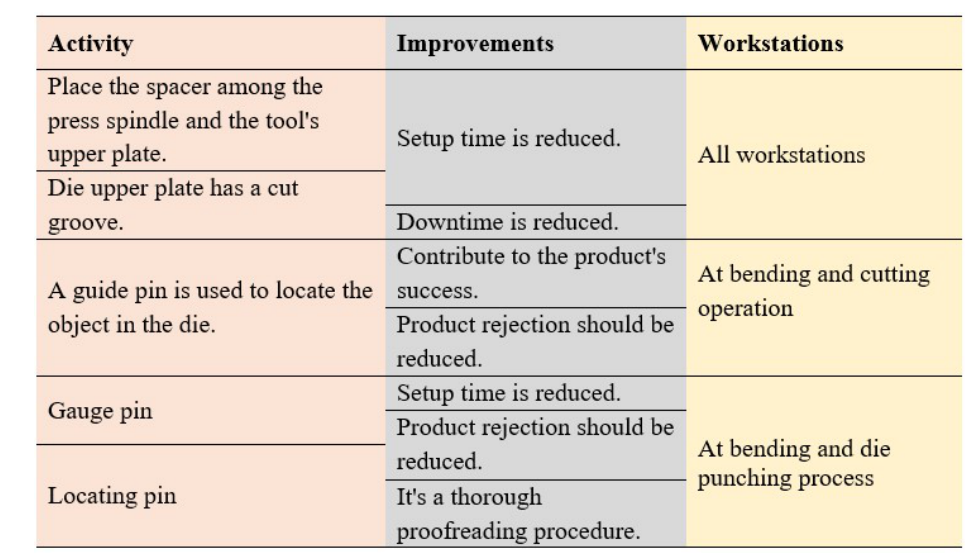
Figure 1. Activity at different workstations ( implementation/adopting the new technique ). Table 5. Mandatory duties of operator and maintenance personnel.